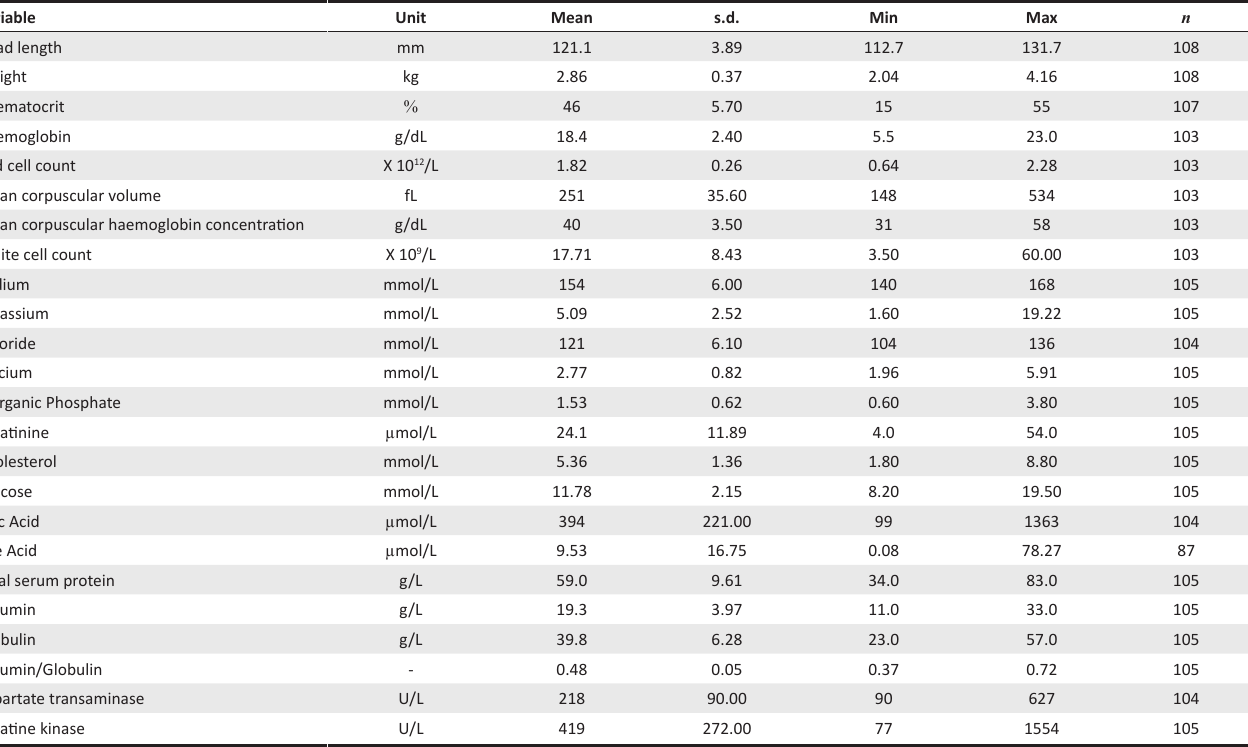
TABLE 1: Haematology and blood chemistry values for wild, healthy, adult African penguins sampled during the breeding season in South African colonies. Variable Unit